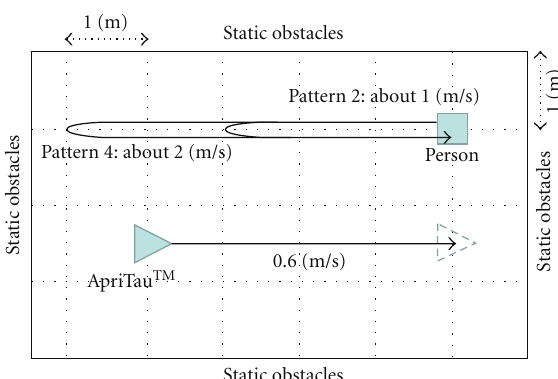
Figure 9: The experimental setting (Pattern 2 and